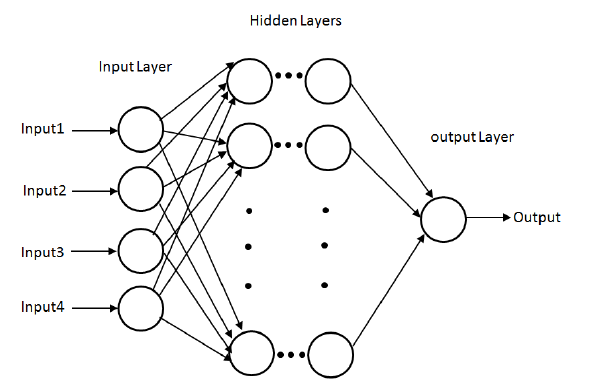
Figure 2: The Block diagram of the ANN